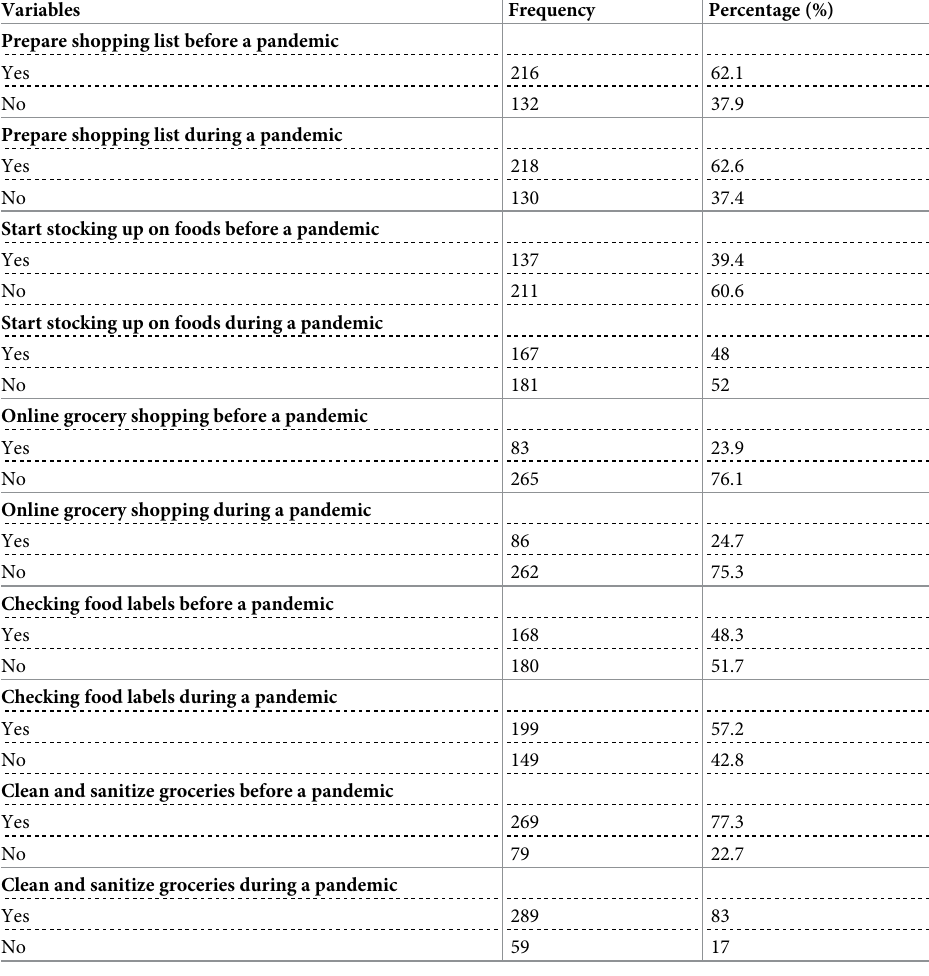
Of the participants, 8.3% and 10.6% participants were emotionally exhausted in all parts of the time before and during the COVID-19 pandemic, respectively. However, the level of irritability before the COVID -19